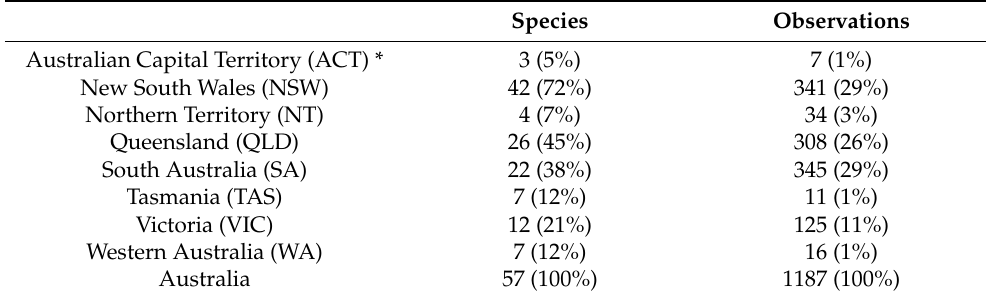
Table 2. Total number and percentage of species richness observed on the Mozzie Monitors project on iNaturalist per state in Australia, from 2000 to 2021. Species Observations